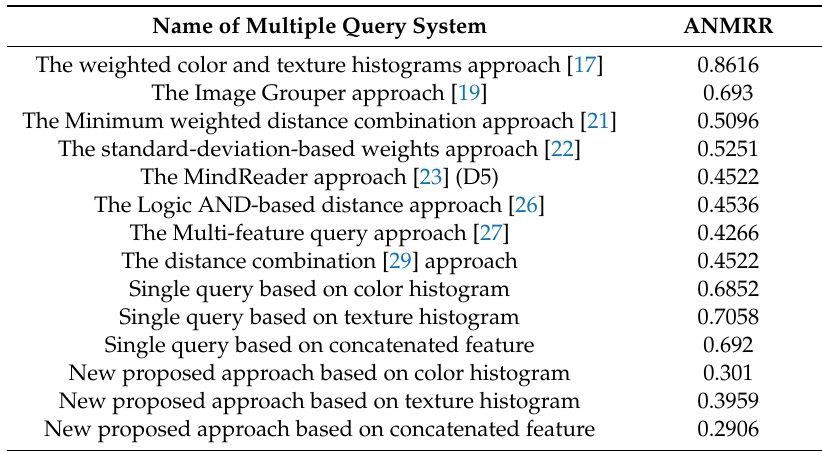
Table 5. The performance of the proposed multiple query approach compared to the existing multiple query approaches and to the single query approach based on ANMRR.